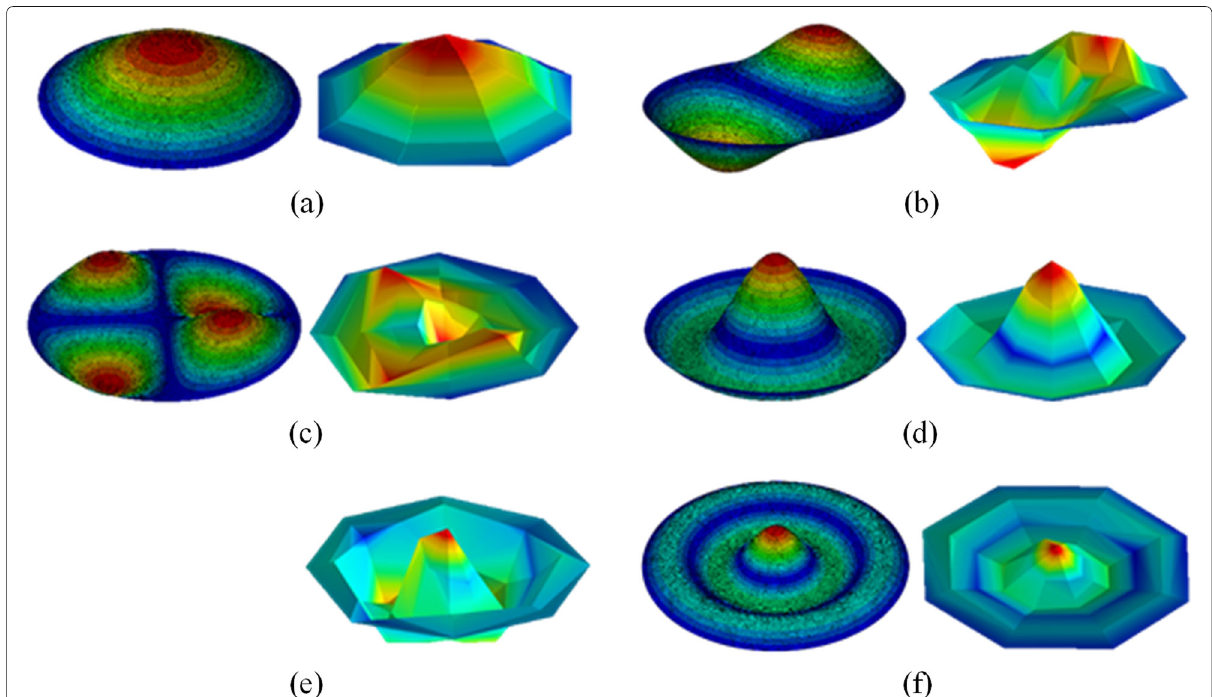
Fig. 18 Comparison of mode shapes using FEA ( left ) and EMA ( right ) for a mode (0,1), b mode (1,1), c mode (2,1), d mode (0,2), e not identified in FEA and f mode (0,3)